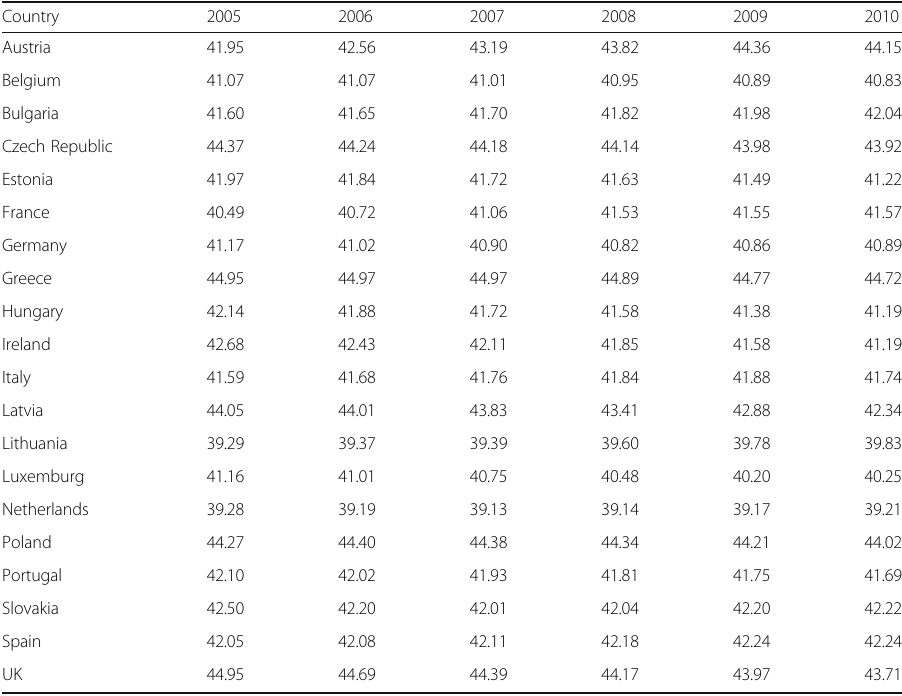
Table 8 Average usual weekly hours worked on the main job by men aged 25 – 54